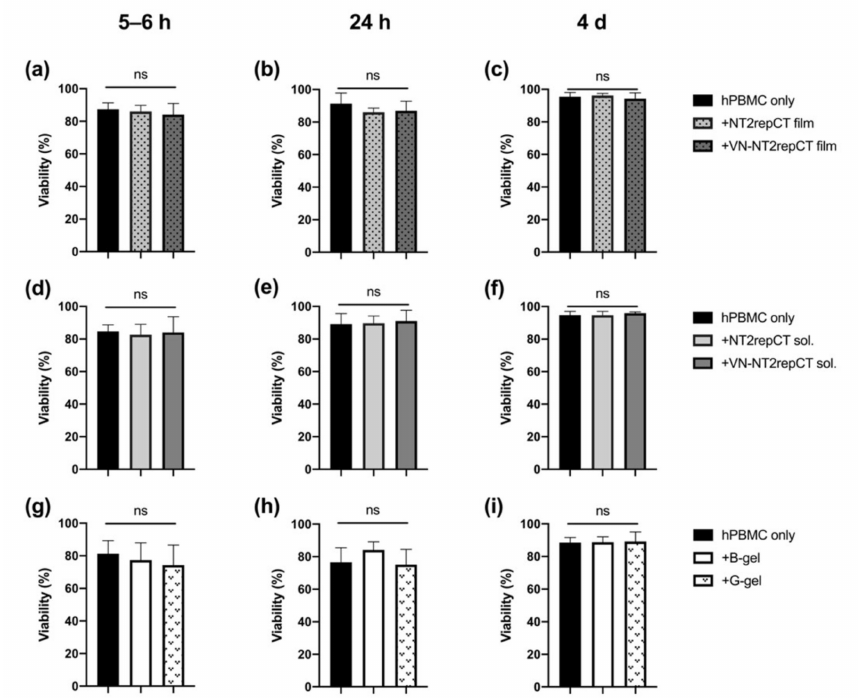
Figure 1. Viability of hPBMCs after exposure to the biomaterials. The hPBMCs were kept in culture with ( a – c ) NT2RepCT and VN–NT2RepCT film, ( d – f ) soluble NT2RepCT and VN–NT2RepCT and ( g – i ) bulk (“B-gel”) and granular (“G-gel”) HA hydrogel for 5–6 h, 24 h and 4 d, and thereafter, the cellular viability was measured. Data are presented as mean + SD. The statistical test repeated measure ANOVA was applied to compare the mean of the experimental groups with the mean of the control group (hPBMC, only). ns: not significant, p > 0.05. n = 4 biologically different